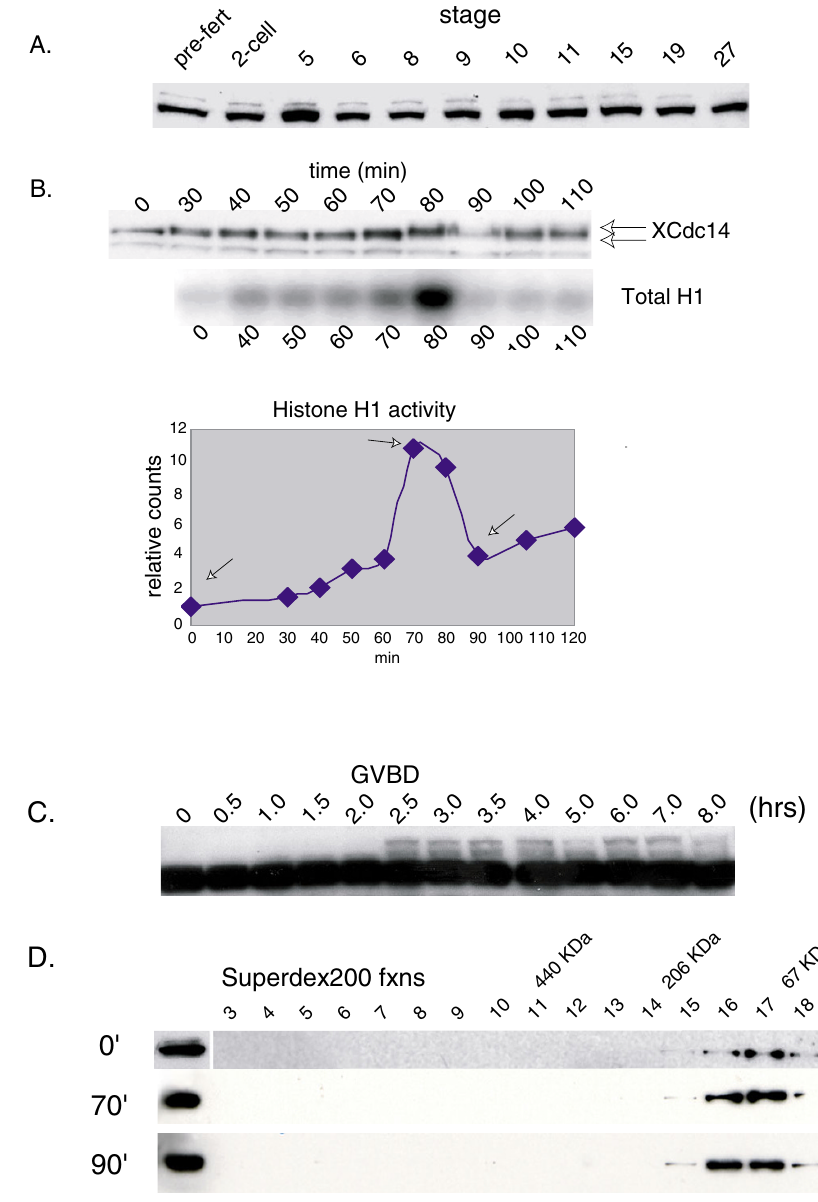
Figure 3 XCdc14 α is mitotically phosphorylated during oocyte maturation and in the Xenopus embryonic cell cycle . A. XCdc14 α protein levels are constant during development. Xenopus eggs were fertilized in vitro and at the indicated stages were frozen down for subsequent immunoblot analysis. B. XCdc14 α is phosphorylated in mitosis in cycling Xenopus extracts. At the indicated times, samples from cycling extracts were frozen in liquid nitrogen for subsequent immunoblot analysis with anti- XCdc14 α antibodies (top panel) and total histone H1 kinase activity (lower panel). For the immunoblot, lysates were resolved on 11% SDS PAGE gels. C. XCdc14 α becomes phosphorylated after germinal vesicle breakdown (GVBD) in the maturing oocyte. Defolliculated Stage VI oocytes were induced to mature by the addition of progesterone (10 µ g/ml). At the indicated times, oocytes were flash frozen for subsequent immunoblot analysis with antibodies against XCdc14 α . GVBD occurred between 2 and 2.5 hrs. D. The majority of XCdc14 α is monomeric or dimeric through the cell cycle. At 0, 70 and 90 min, sam- ples from cycling extract were flash frozen in liquid nitrogen. Left: samples from the cycling extract were tested for total his- tone H1 kinase activity. Arrows indicate timepoints that were analyzed. Right: The frozen samples were diluted 10-fold in XB buffer, and 50 µ g (1 µ l equivalent of undiluted lysate) was fractionated on a Superdex200 gel filtration and probed with anti- XCdc14 α antibodies. The elution profiles of molecular weight standards are depicted above the